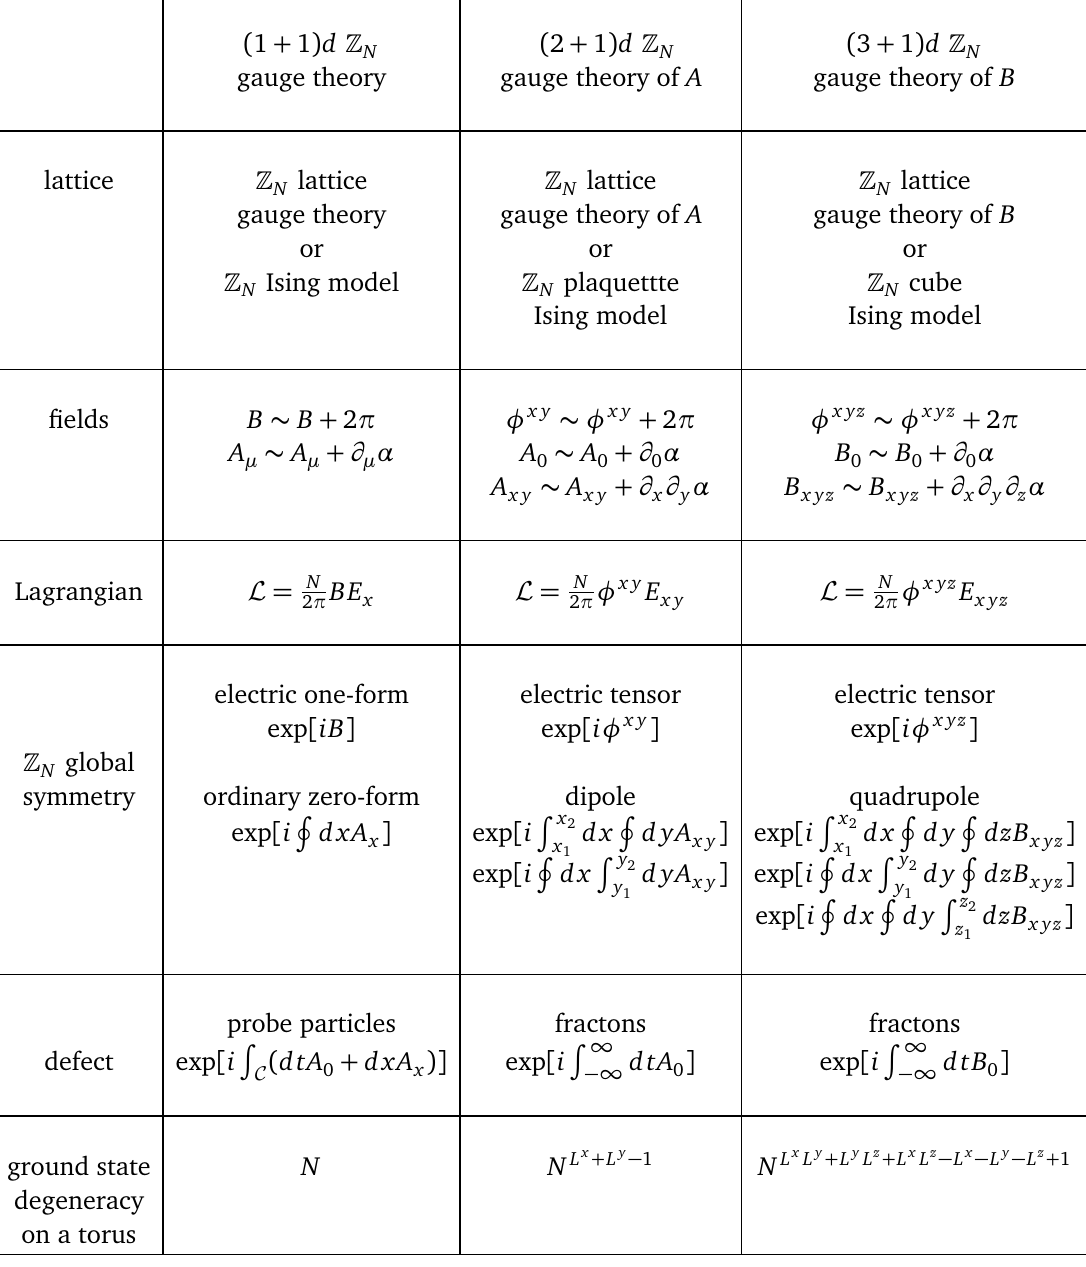
gauge theory, the N gauge N